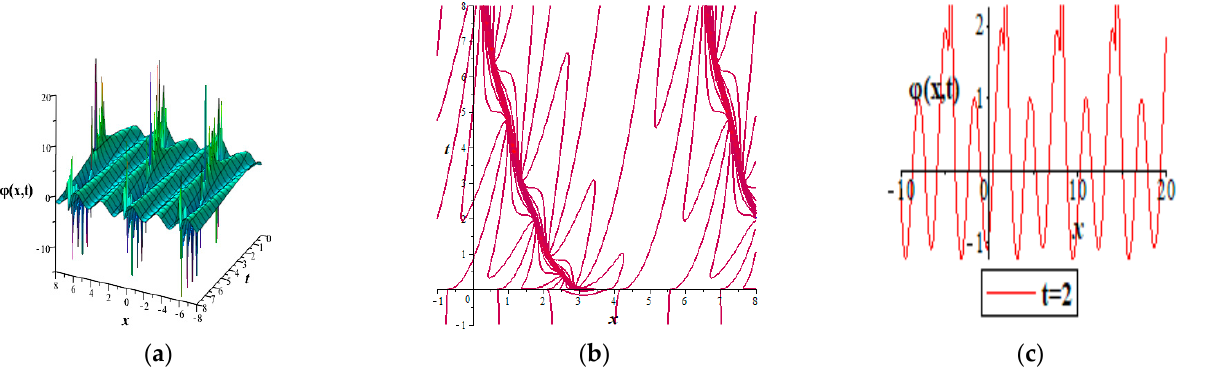
ϕ Figure 1. ( a – c ) Representation of real part of wave ),( tx of Equation (23) for the parametric Figure 1. ( a – c ) Representation of real part of wave φ ( x , t ) of Equation (23) for the parametric situations −==== ghk γ = t k = 0.5, γ = 0.5, h = 1, g = − 2 and t = 2 for 2D graph. ( a ) Real surface in 3D; ( b ) Real shape in and 2 for 2D graph. ( a ) Real surface in 3D; ( b ) situations 2,1,5.0,5.0 contour; ( c ) Real shape in Real shape in contour; ( c ) Real shape in 2D.